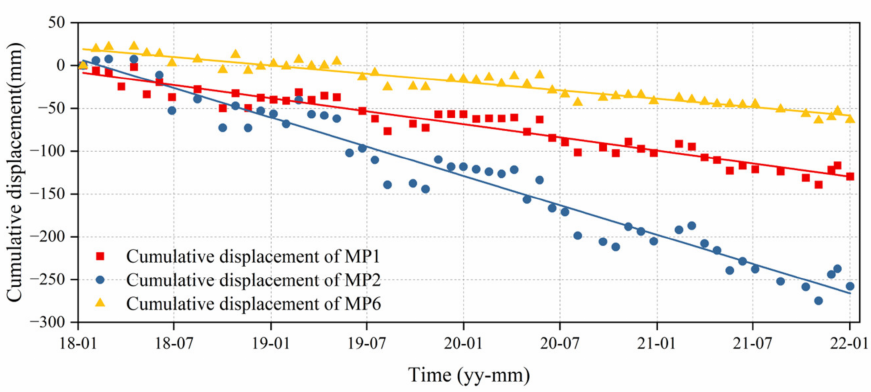
Figure 10. Cumulative displacement curves and the corresponding Hurst index of MP1, MP2 and MP6.